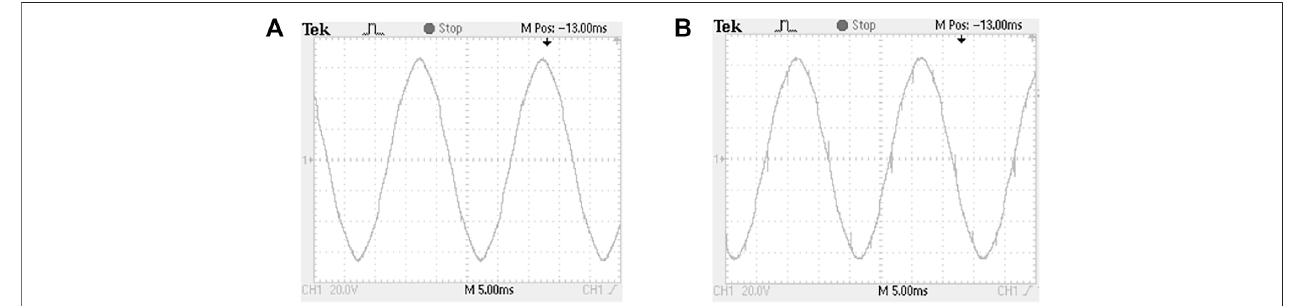
FIGURE 3 | Two signals with typical power quality problems in an actual traction